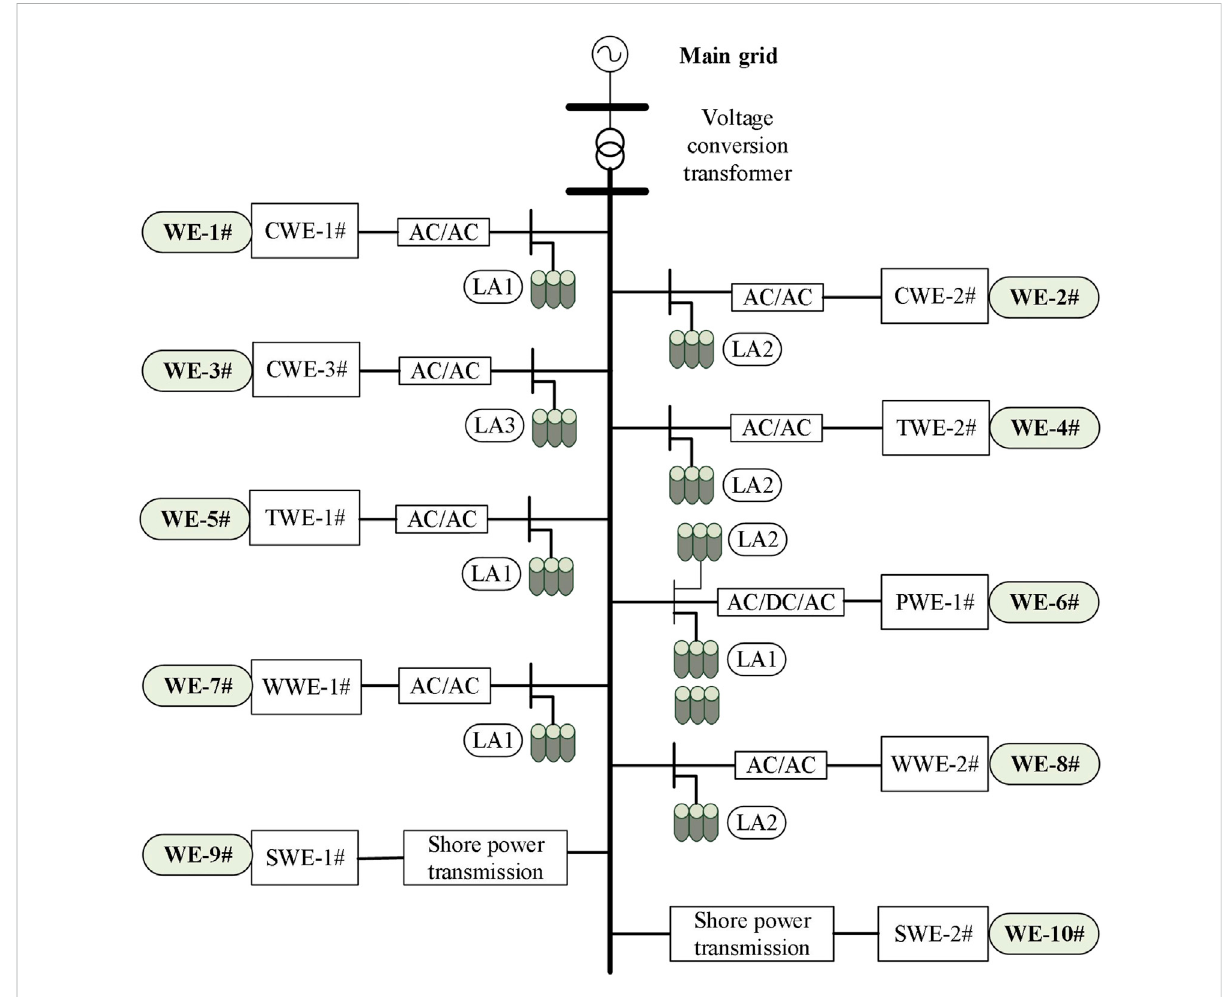
FIGURE 2 Simulation and validation model of a port microgrid based on